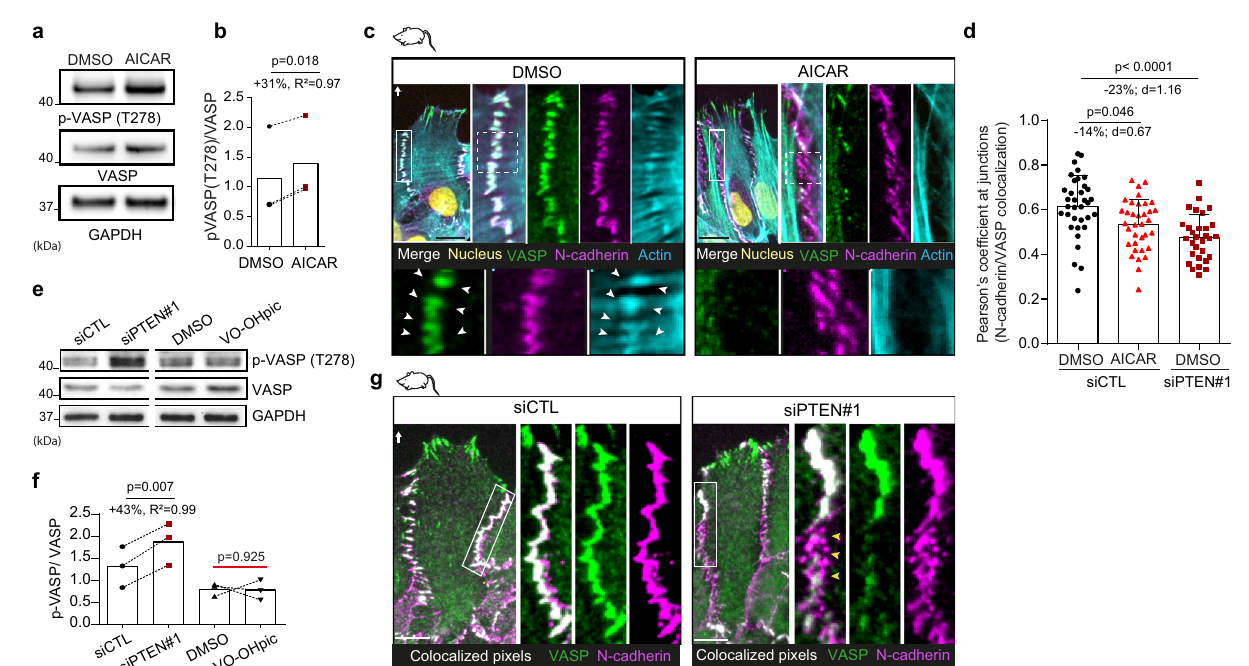
Fig. 4 AMPK activation controls VASP phosphorylation and localisation at cell-cell junction. a , e Western blot analysis of phosphorylated VASP (T278), total VASP and GAPDH in DMSO- and AICAR-treated astrocytes ( a ) and siCTL, siPTEN#1, DMSO- and VO-OHpic-treated cells ( e ). b , f Ratio of pVASP/ VASP in DMSO- vs AICAR-treated cells ( b , + 31%, N = 3, two-tailed paired t -test), in siCTL vs siPTEN#1 cells ( f , + 43%, N = 3, two-tailed paired t -test) and in DMSO- vs VO-OHpic-treated cells ( f , N = 3, two-tailed paired t -test). c Immuno fl uorescence images of VASP (green), N-cadherin (magenta), F-actin (cyan) and DAPA (yellow) in DMSO- and AICAR-treated cells. White rectangles area are zoomed in the top panel. Dotted-line squares in the zoomed area are further zoomed in the bottom panels. Cell-cell junctions enriched in VASP associate with ITA anchoring (white arrowheads). Note that the absence of VASP at cell-cell junctions in AICAR-treated cells is associated with the absence of ITA. d Pearson ’ s coef fi cient of colocalized junctional N-cadherin with VASP in DMSO- and AICAR-treated siCTL cells ( n = 35 cells analysed from three biologically independent experiments) and in DMSO-treated siPTEN cells ( n = 30 cells analysed from three biologically independent experiments). Two-tailed unpaired t -test was used to derive p values. The drop in Pearson ’ s coef fi cient highlights the loss of VASP colocalisation with junctional N-cadherin in AICAR-treated and PTEN depleted cells. g Immuno fl uorescence images of VASP (green), N-cadherin (magenta) and colocalized pixels between N-cadherin and VASP (white) in siCTL and siPTEN#1 cells. White rectangles area are zoomed-in. Scale bars: 10 µ m. Note the disappearance of colocalized pixels in large part of cell-cell junctions in siPTEN#1 cells (yellow arrowheads). Error bars represent SD. Full scan images of the blots and source data are provided as a Source Data fi